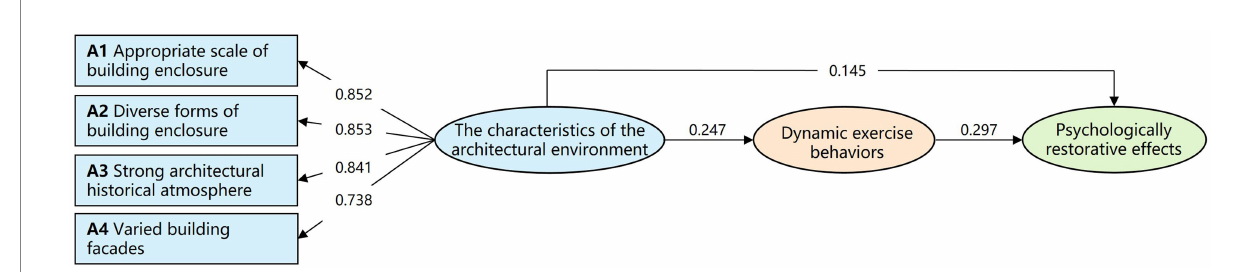
FIGURE 7 Influence effect illustration of the characteristics of the architectural